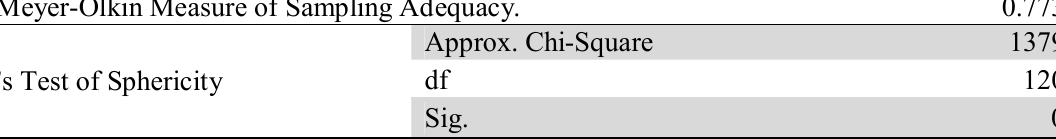
KMO and Bartlett's Test